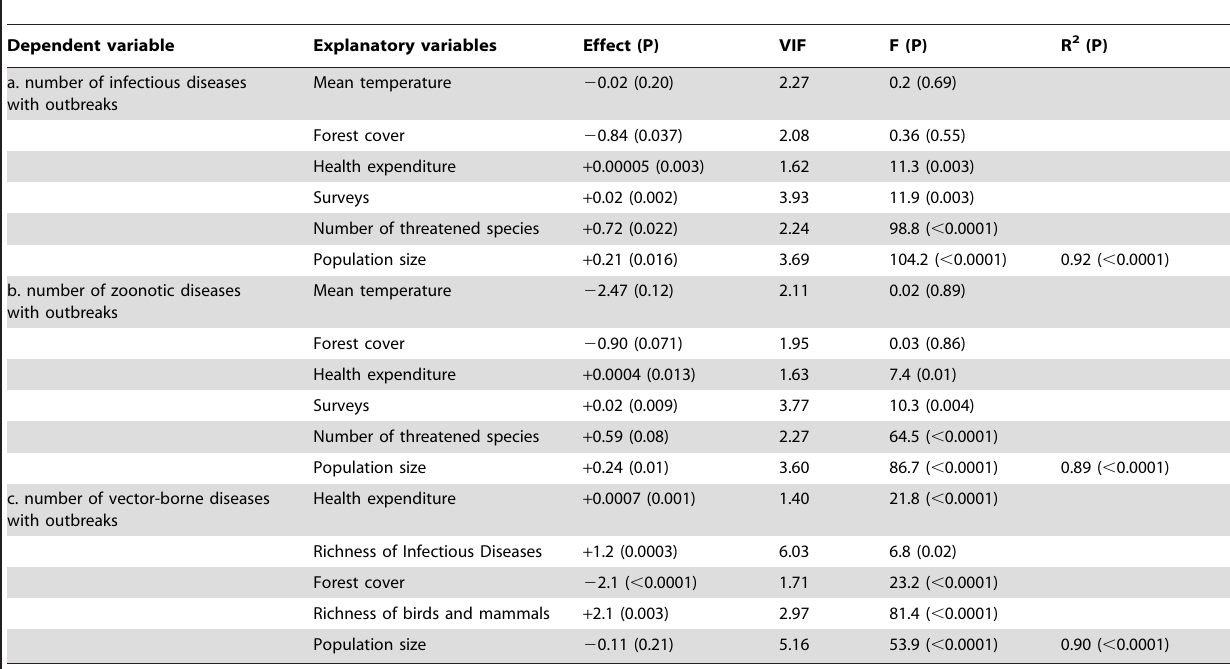
Table 2. Summarized results for a General Linear Model explaining the number of infectious diseases with epidemics (total, zoonotic and vector-borne) in